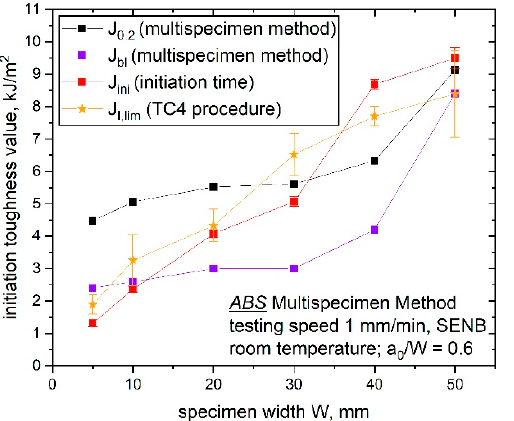
Figure 15. Comparison of initiation toughness parameters J 0.2 (multispecimen procedure), J bl (multispecimen procedure) J ini (based on the initiation time t ini ) and J I,limi (ESIS TC 4 draft protocol) for increasing specimen sizes of 5, 10, 20, 30, 40 and 50 mm (adapted from [7]). The initiation value J 0.2 displayed the highest values for small specimen sizes as com- pared to the other assessed initiation parameters. For the specimen sizes of 10 to 40 mm,